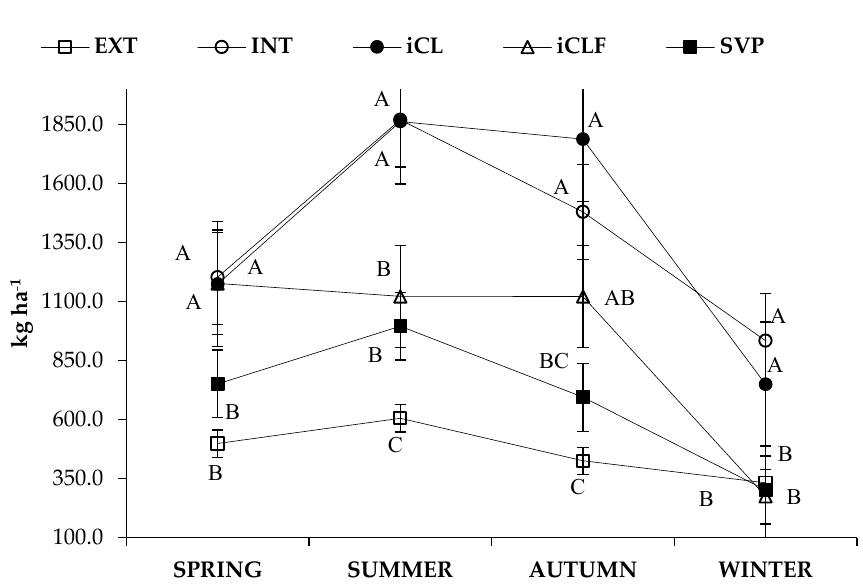
Figure A1. Dry mass availability during seasons from different livestock production systems (means of two years). Different letters in the same season differ from each other ( p < 0.05) according to the